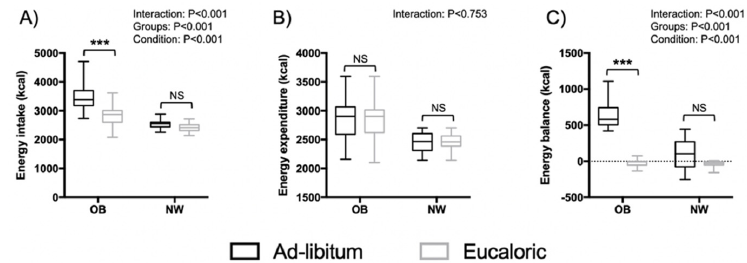
Figure 2. Energy intake ( A ), energy expenditure ( B ) and energy balance ( C ) among OB and NW during ad libitum and eucaloric sessions. OB: adolescents with obesity, NW: normal weight age matched controls, NS: non-significant, ***: significant difference in Post hoc pairwise comparisons (ad libitum vs. eucaloric) with p < 0.001.